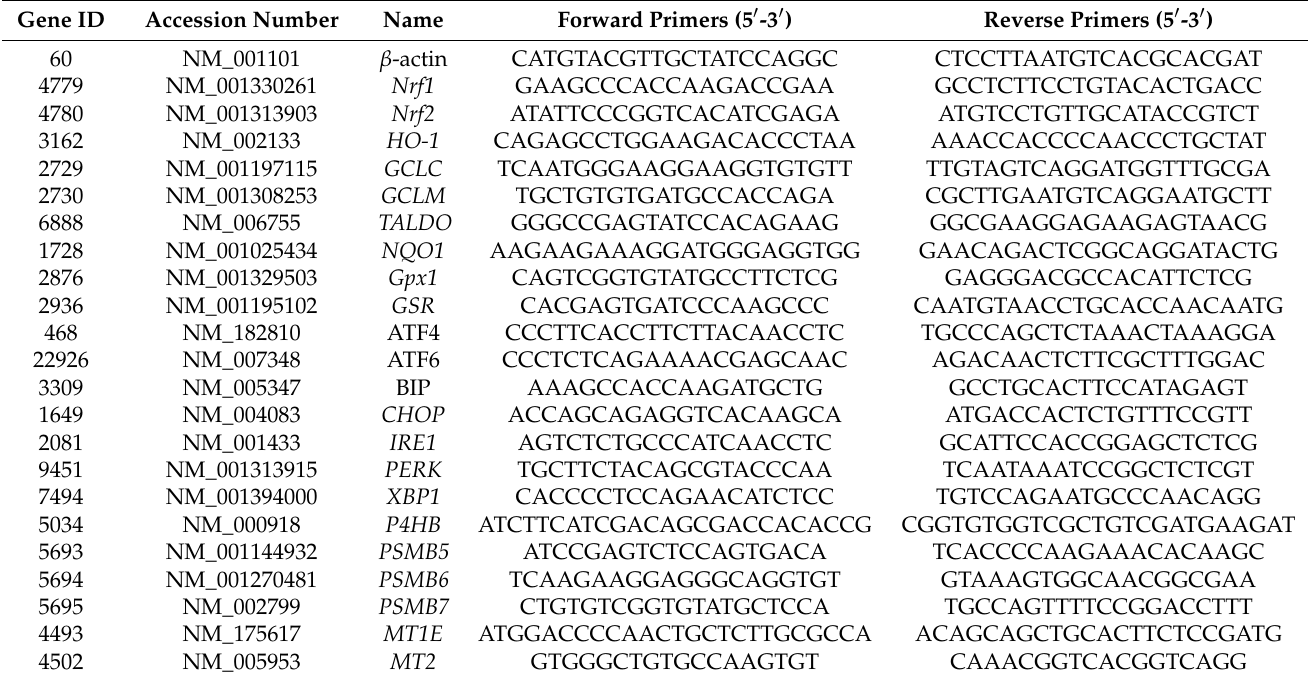
Table 1. The primer pairs used for q-RT-PCR